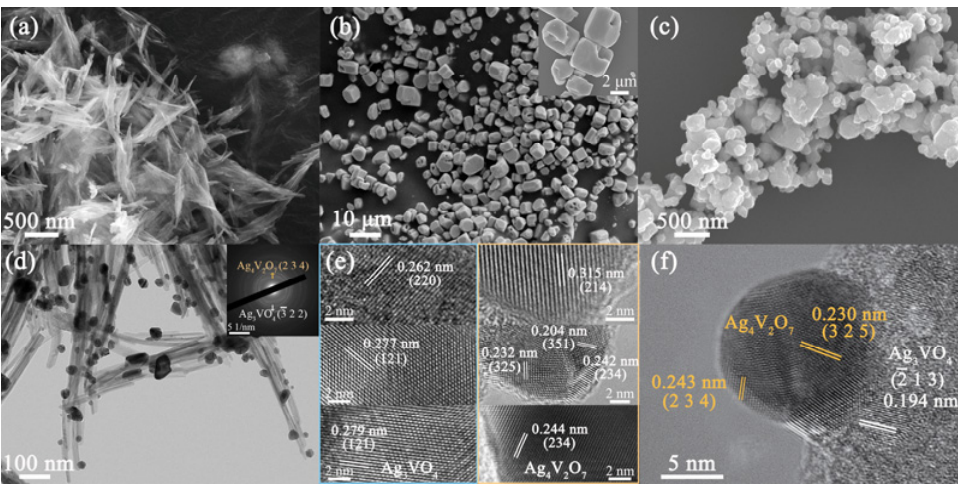
Fig. 3 SEM images of (a) AgVO 3 (pH = 6), (b) Ag 4 V 2 O 7 , and (c) Ag 3 VO 4 ; TEM and SAED images of (d) BAVO heterojunction; and HRTEM images of (e) Ag 3 VO 4 nanorods and Ag 4 V 2 O 7 nanoparticles and (f) interface of BAVO